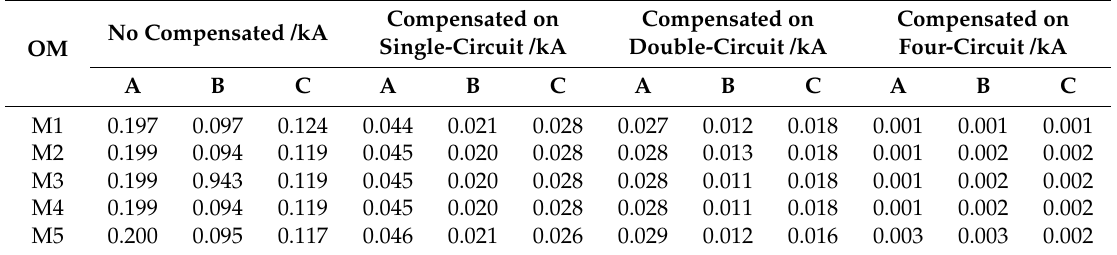
Table 1. Three-phase differential current under different operation modes.